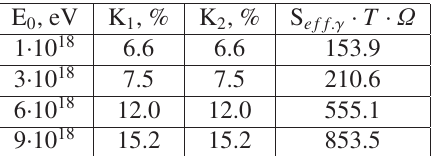
Figure 3. Dependence of X max on energy. Experimental data